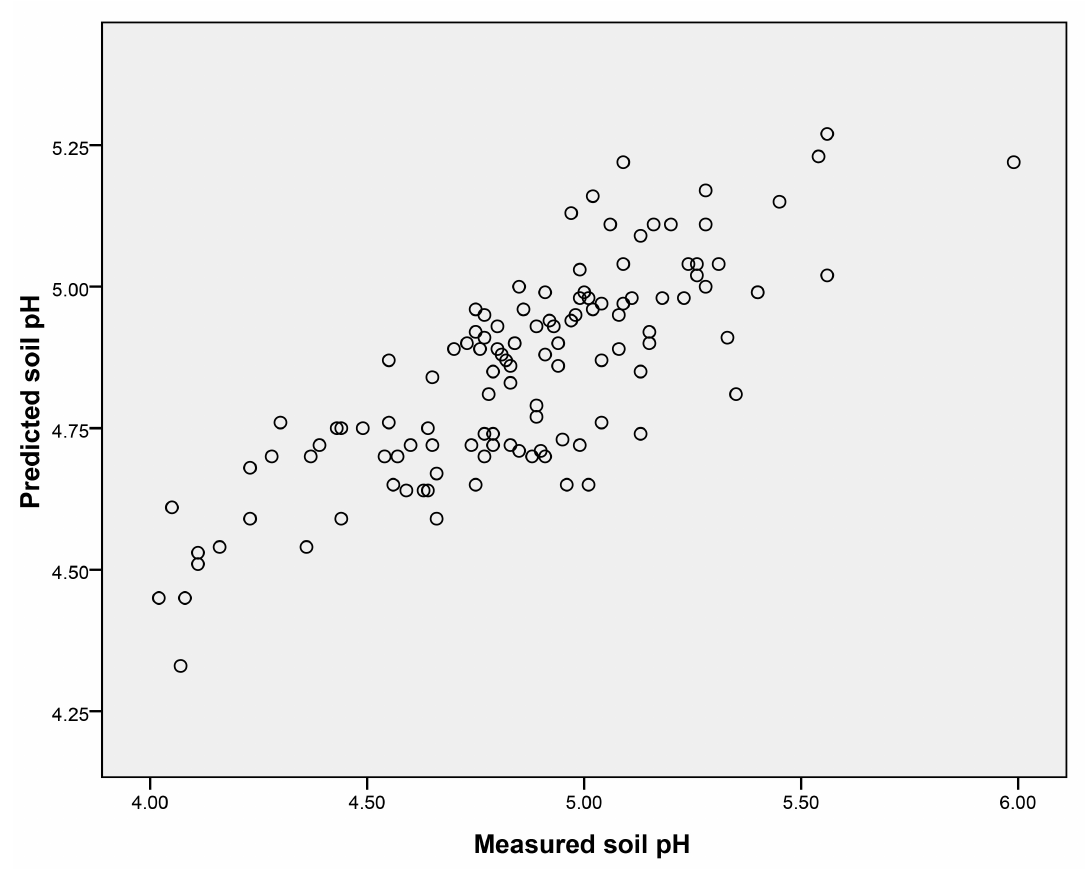
Figure 4. Cross plot of measured and predicted soil pH